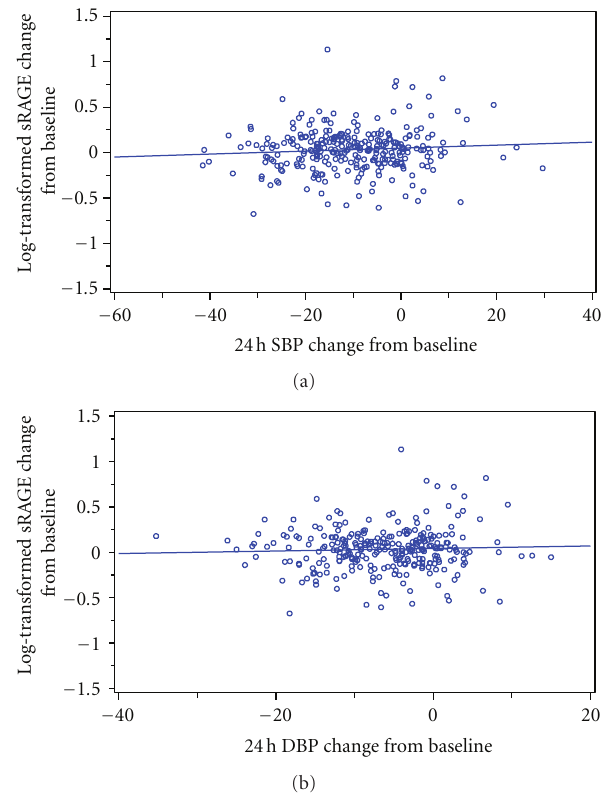
Figure 1: Log-transformed sRAGE by 24 hour systolic (a) and dias- tolic (b) blood pressure change from baselin at week